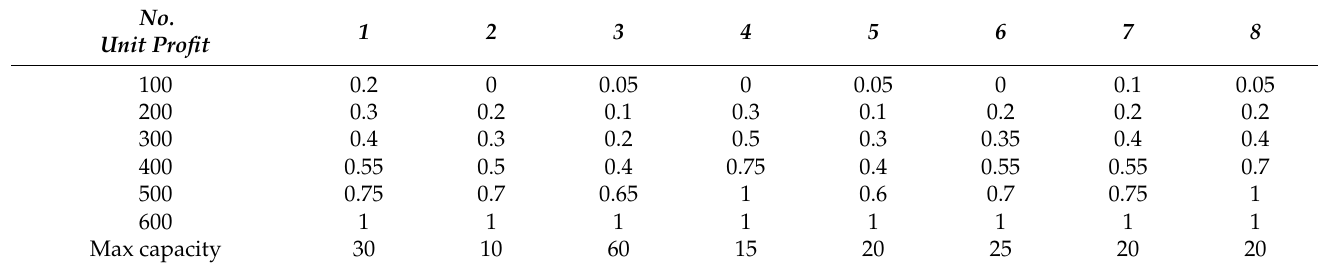
Table 2. The intention percentage of max disposal capacity of the 3P in different unit profits.